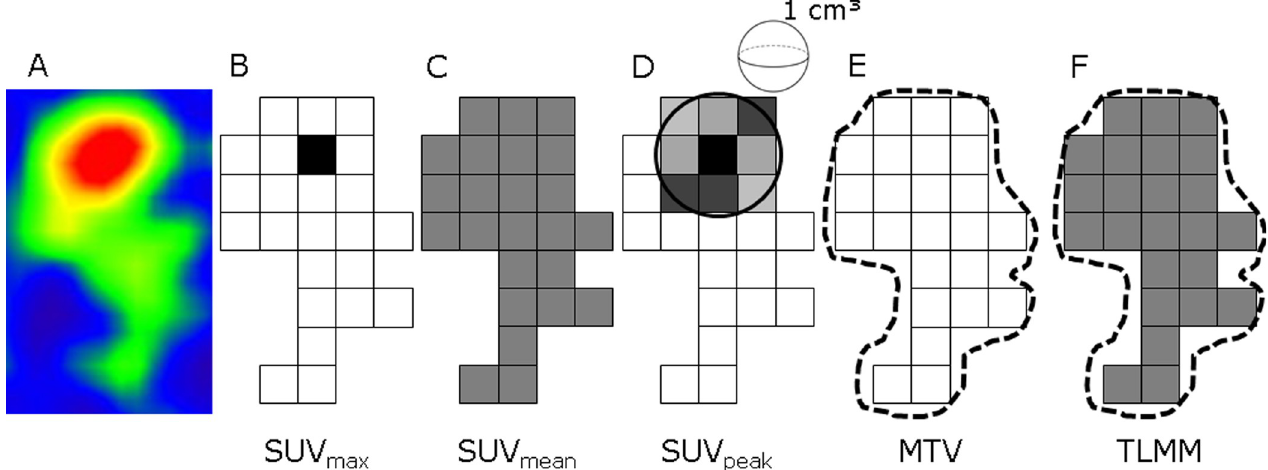
Fig 1. Schematic overview of metabolic and volume-based 11 C-MET PET parameters. (A) Snapshot of lesion with positive uptake of 11C-MET. (B) SUVmax is defined as voxel with highest uptake within the lesion. (C) SUVmean is an average of all SUV values from included voxels within the lesion. (D) SUVpeak is defined as the average value within a 1cm 3 sphere surrounding the SUVmax. Volume-based parameters are shown in E-F. (E) MTV is the volume of increased uptake within the lesion borders. (F) For TLMM the SUVmean and MTV within lesion borders are combined and multiplied to provide both metabolic and volume-based information. TLMM is automatically calculated and extracted within the Syngo.via software. Abbreviations: MTV = metabolic tumor volume, SUV = standardized uptake value, TLMM = total lesion methionine metabolism.